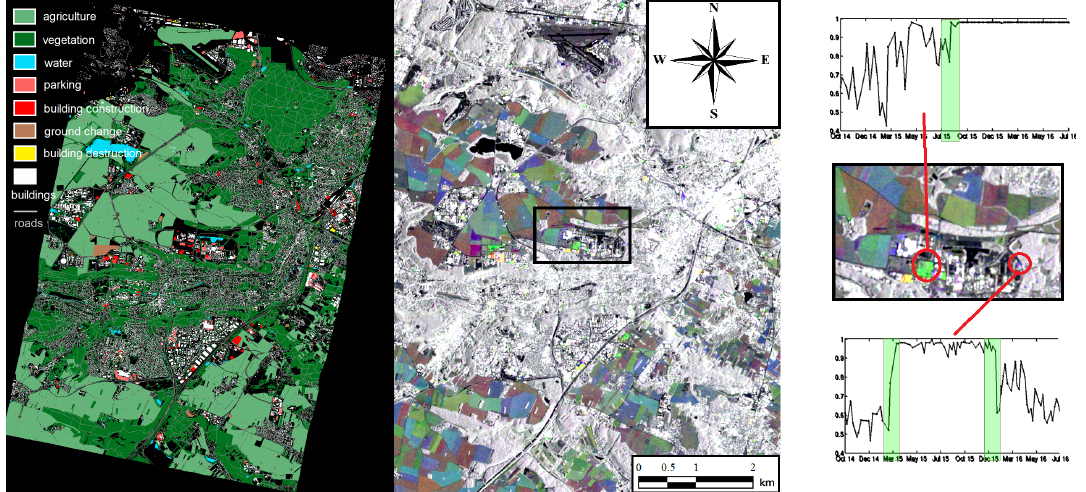
Figure 7. Ground truth established on a test site around Saclay,